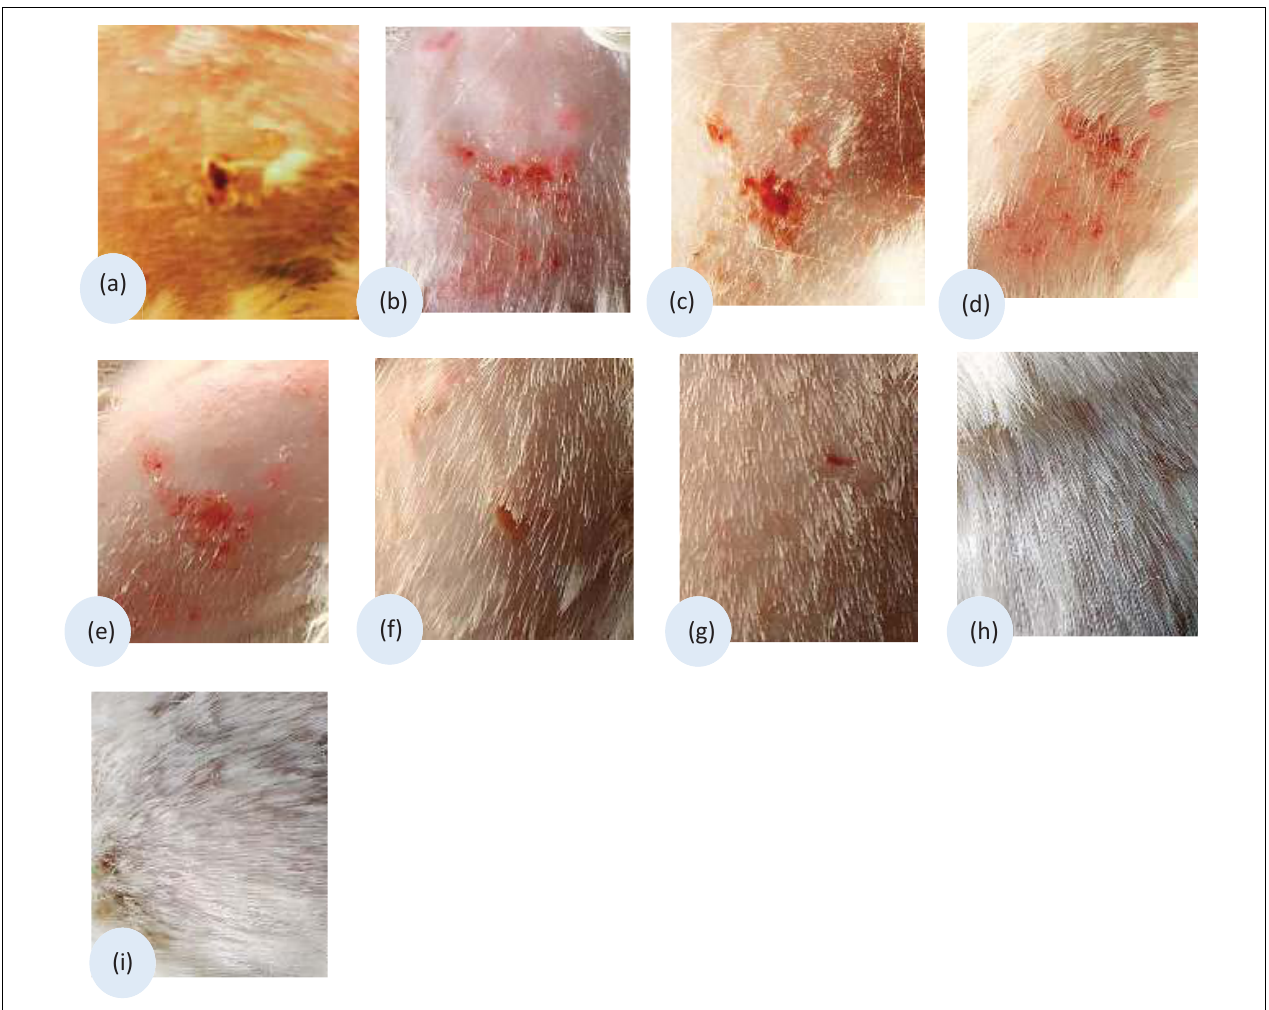
FIGURE 5 | Clinical appearance of the infected sites of guinea pigs dermatophytosis model before, model group (a) and after subjection to different treatment using the medicated films, (b) placebo film (P); (c) U10; (d) U20; (e) U40; (f) Positive control treated with miconazole film (M); (g) combination treated group M + U10; (h) M + U20; and (i) M + U40. Representative photos of the infected areas captured on the 13th day of the study.